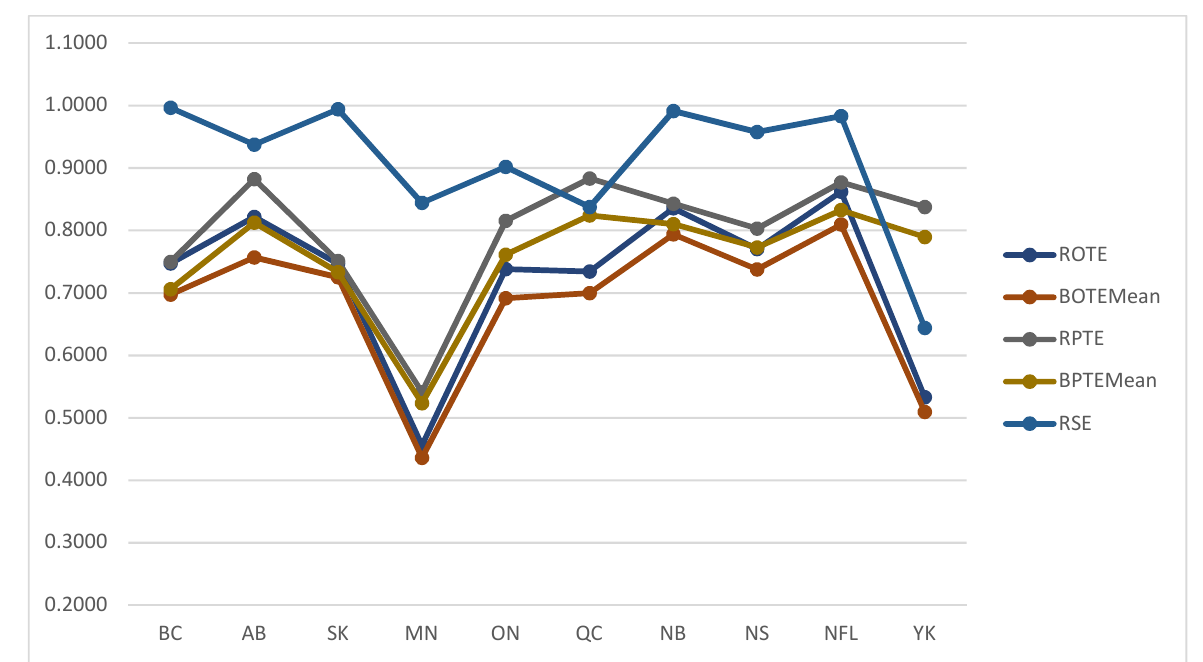
Figure 4. Efficiency scores of the power-generating companies per province/territory.